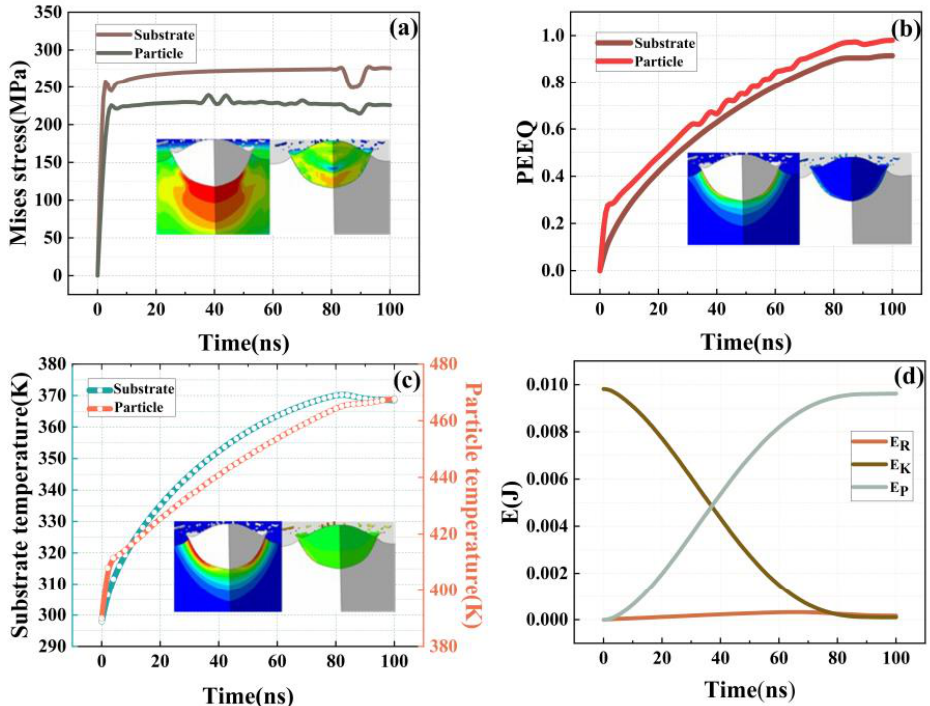
Figure 7. Post-processed simulation results. ( a ) Stress evolution of aluminum particles and matrix with time. ( b ) Evolution of plastic strain of aluminum particles and matrix with time. ( c ) Evolution of temperature of aluminum particles and matrix with time. ( d ) Evolution of overall kinetic energy (EK), plastic strain energy (EP), and internal contact elastic energy (ER) with time.